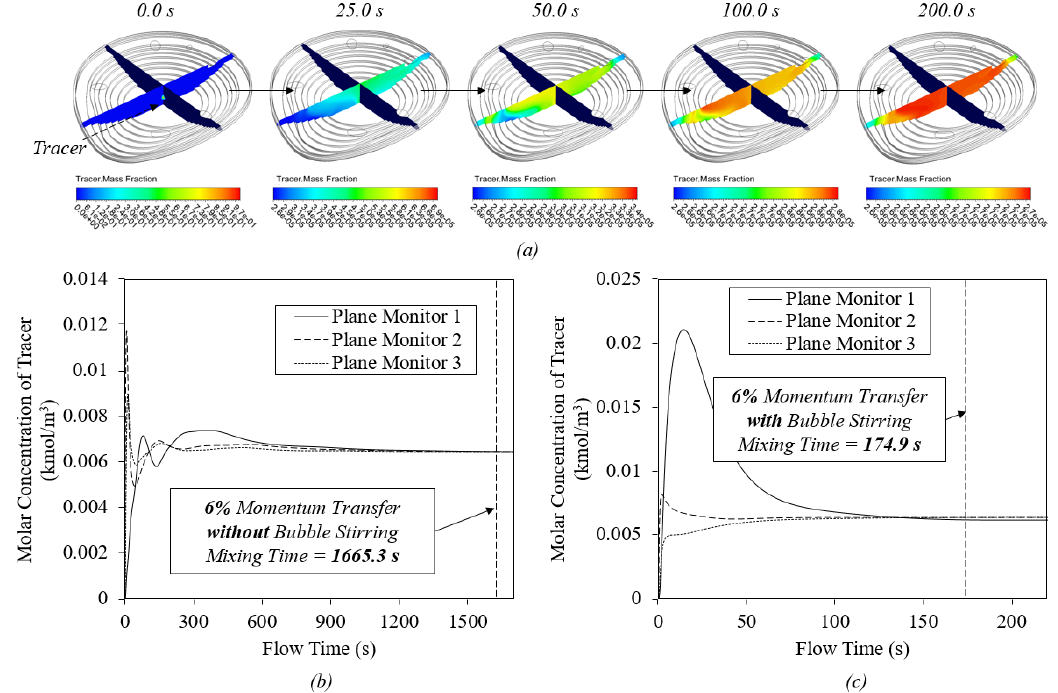
Figure 9. ( a ) In-bath tracer mass fraction over time (with momentum transfer and bubble stirring); ( b ) Mixing time of flow field without bubble stirring; ( c ) Mixing time of flow field with bubble stirring.